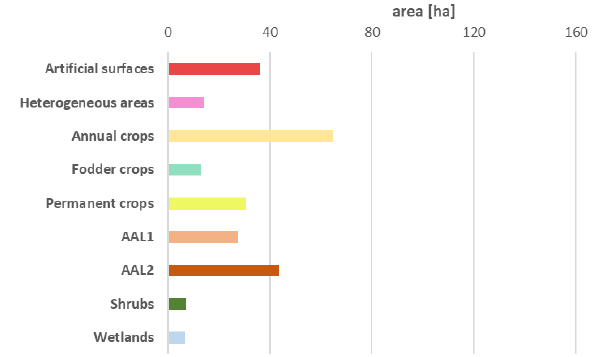
Figure 5. Spatial distribution of validation samples